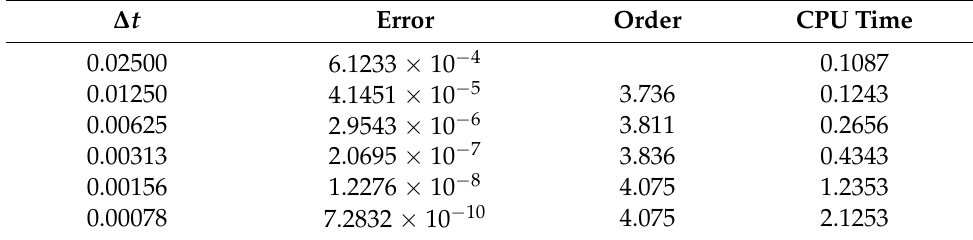
Figure 5. Exact and numerical solutions of Example 2 with ∆ x = 0.04 and ∆ y = 0.02. Table 2. Example 2: Convergence results for the time-stepping